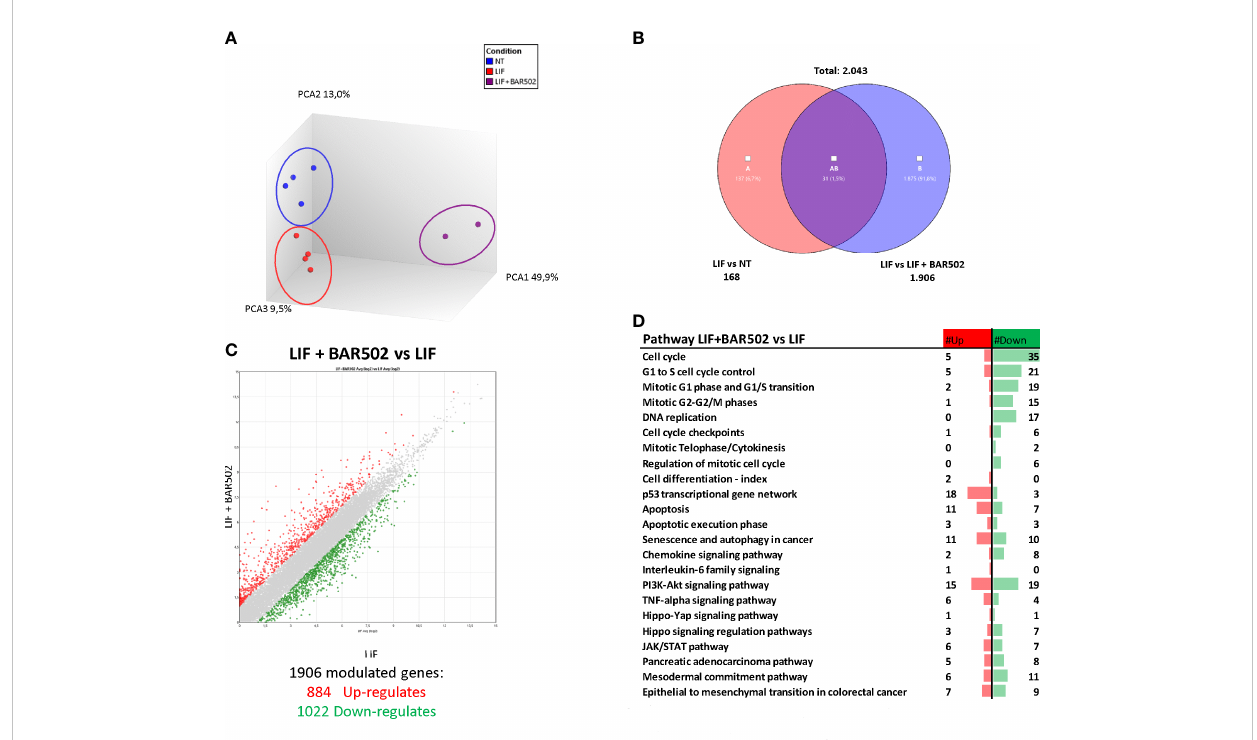
FIGURE 8 RNA-seq analysis of BAR502 effects on MIA PaCa-2 cells exposed to LIF alone or in combination with BAR502. MIA PaCa-2 cells were serum- starved for 24 hours and exposed to LIF (10 ng/mL) alone or in combination with increasing concentrations of BAR502 (10 m M) for 24 hours. (A) Heterogeneity characterization of the three experimental groups as shown by principal component analysis (PCA) plot. (B) Venn diagram of differentially expressed genes showing the overlapping region between the three experimental groups. (C) Scatter plots of transcripts differentially expressed between different experimental groups (fold change < − 2 or >+2, p value < 0.05). Red dots represent signi fi cantly upregulated genes, and green dots represent signi fi cantly downregulated genes. (D) Table showing pathway modulated by LIF plus BAR502 versus